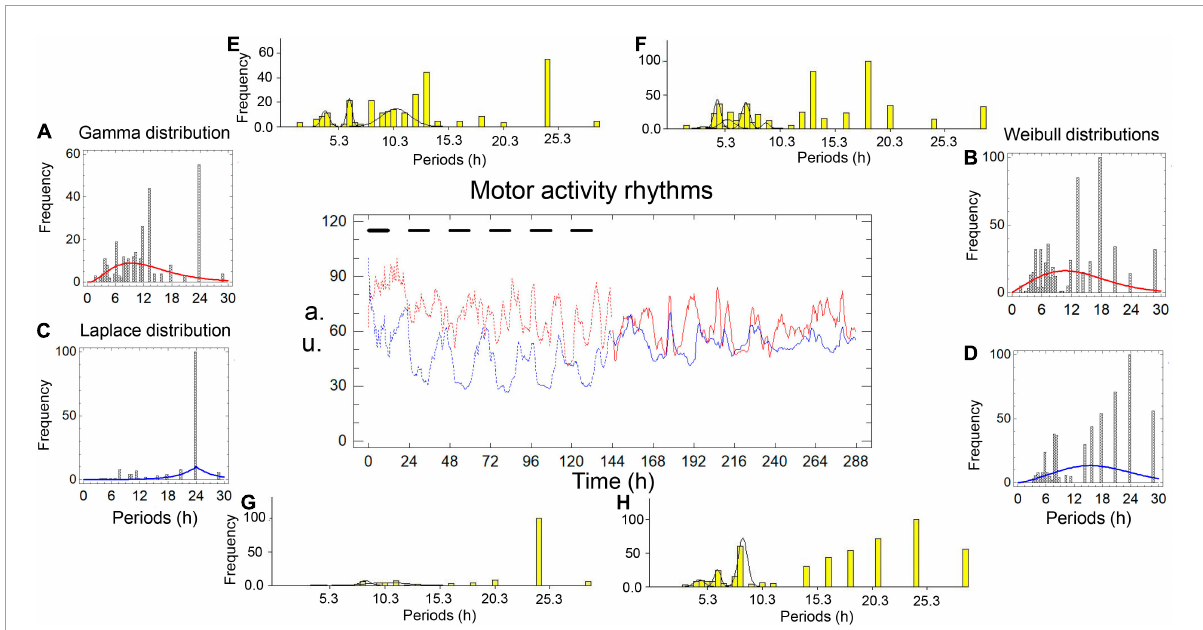
FIGURE1 Motor activity rhythms of the chelipeds of a crayfish under entrainment and during freerunning. In the central graph, the independent variable is time, measured in hours; the dependent variables are the amount of spontaneous activity, measured in arbitrary units (a.u.). The black bars represent the dark phase of the dark-light cycle. The record from the left cheliped (Lc) is the red line, and the record from the right cheliped (Rc) is the blue line. The broken lines represent the entrained rhythms (En) under dark-light cycles (DL, 12:12) for 6 days, and the solid lines represent the freerunning rhythms (Fr) under constant light (LL) for another 6 days. Panels A–D are periodograms and models of the probability distributions. Panels E–H are periodograms and Gaussian